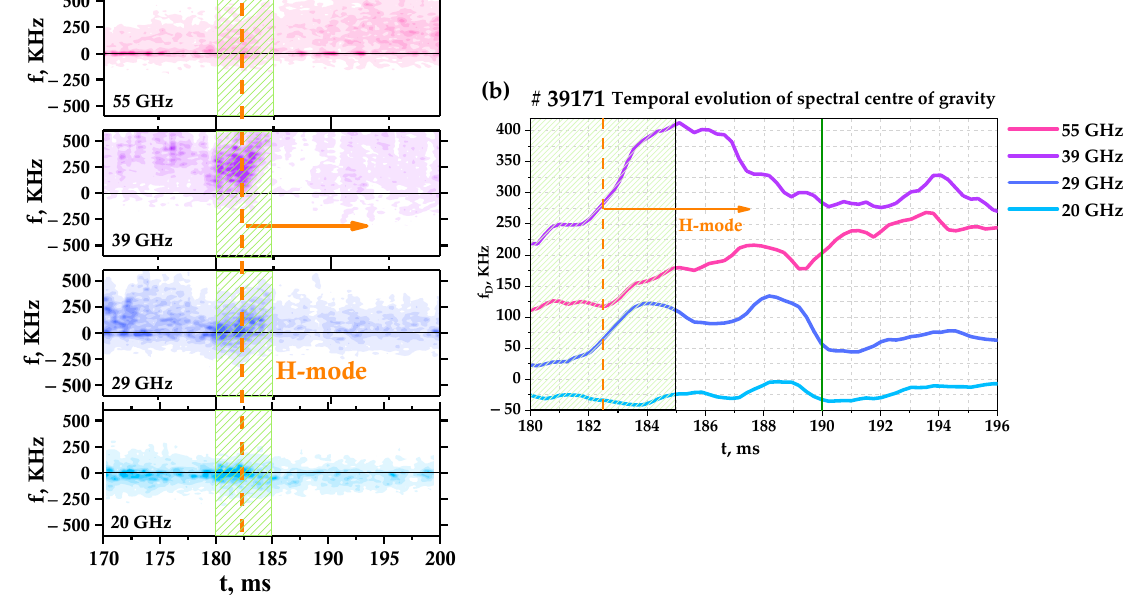
Figure 7. ( a ) Spectrograms of DBS complex signals for discharge #39171 and ( b ) temporal evolution of spectral center of gravity.